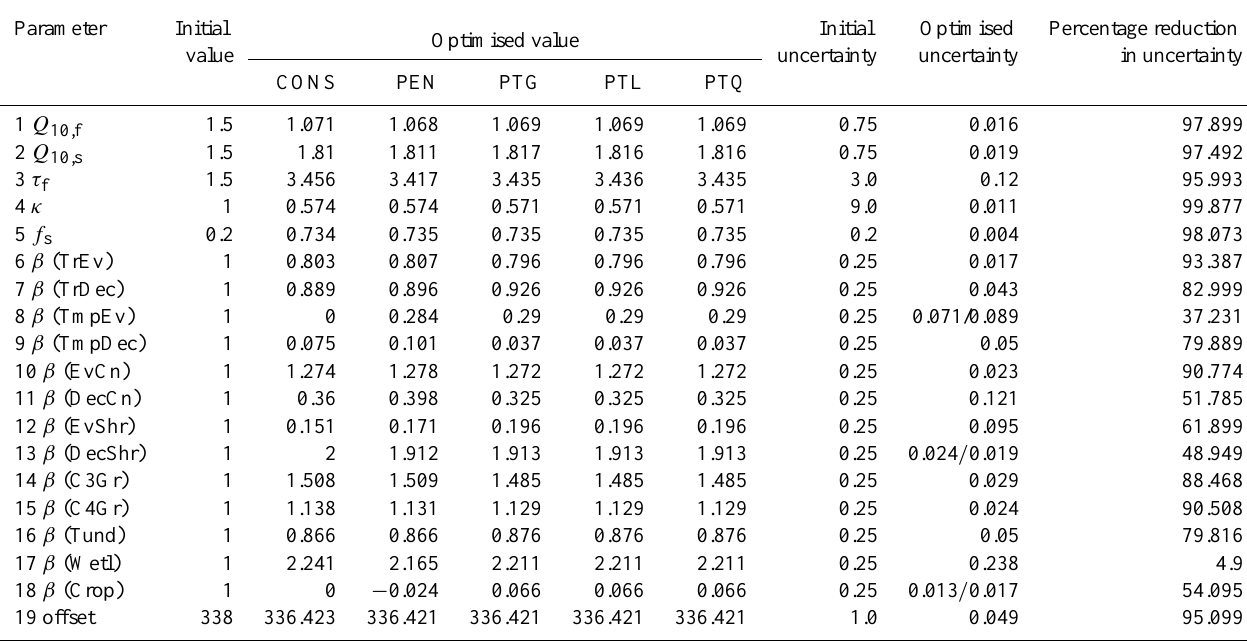
Table 3. Controlling parameters and their initial and optimised values for each experiment, and parameters’ initial and posterior uncertainty (equivalent to one standard deviation) and percentage reduction in uncertainty (relative to the upper standard deviation) after the optimisation for the parameter transformation experiments. For the three β parameters that were transformed using the double-bounded log transformation, upper and lower percentiles, equivalent to one standard deviation, are shown.